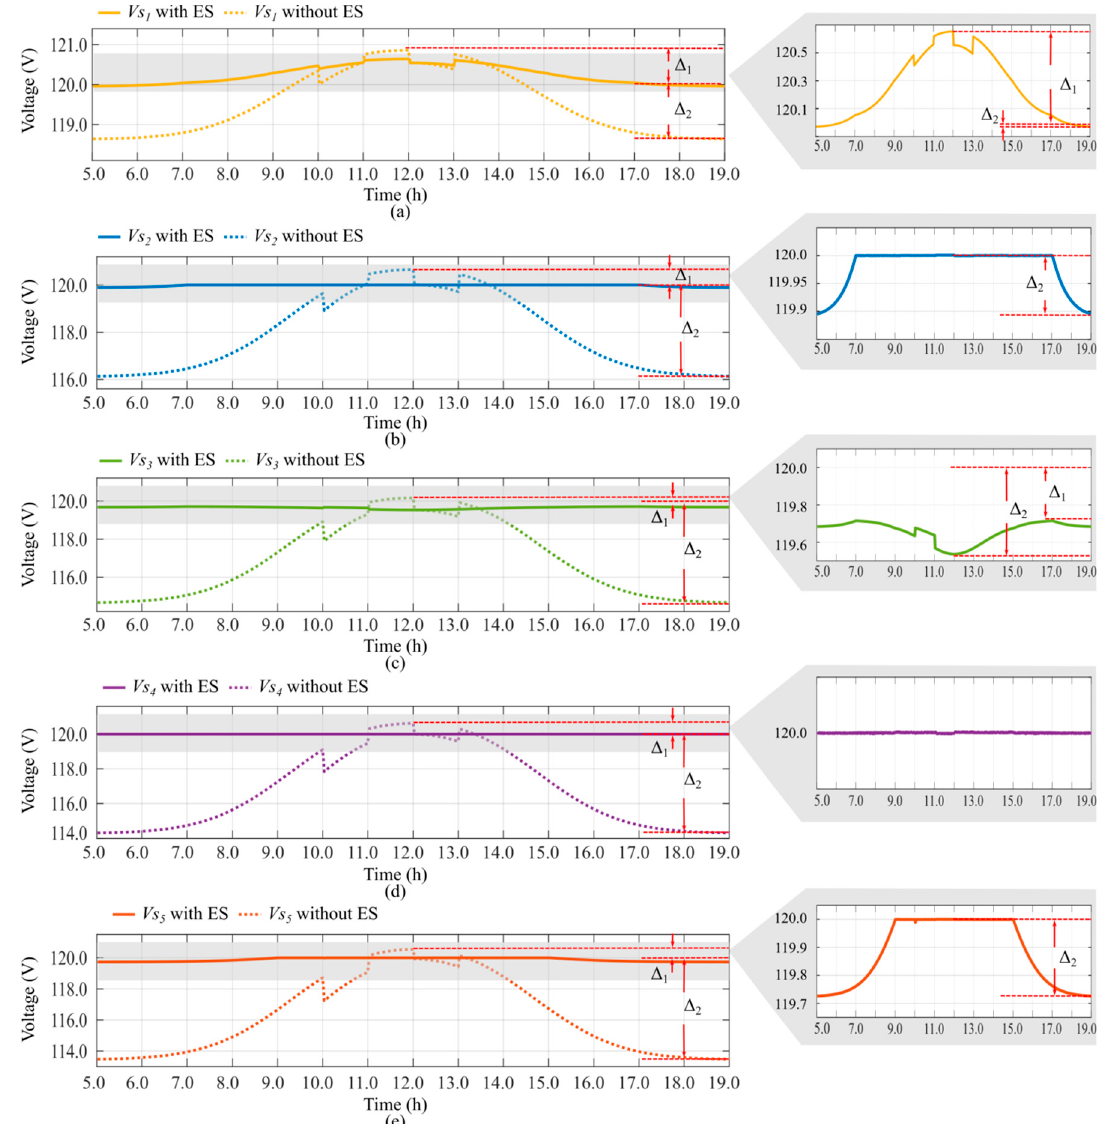
Figure 12. Quasi-stationary node voltages with ESs and without ESs. ( a ) Voltage Vs 1 , ( b ) Voltage Vs 2 , ( c ) Voltage Vs 3 , ( d ) Voltage Vs 4 , ( e ) Voltage Vs 5 .